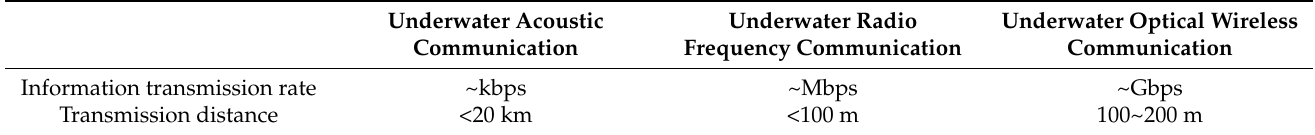
Table 1. Different underwater wireless communication